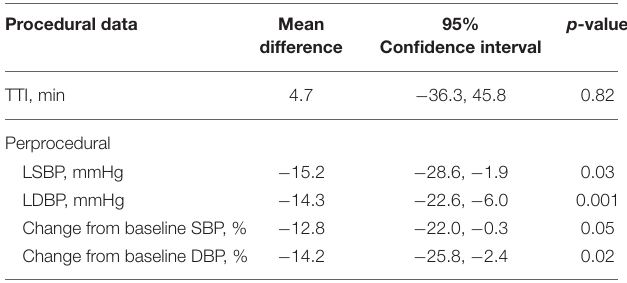
TABLE 2 | Perprocedural data in GA-policy and CS-policy groups after adjustment. Procedural data